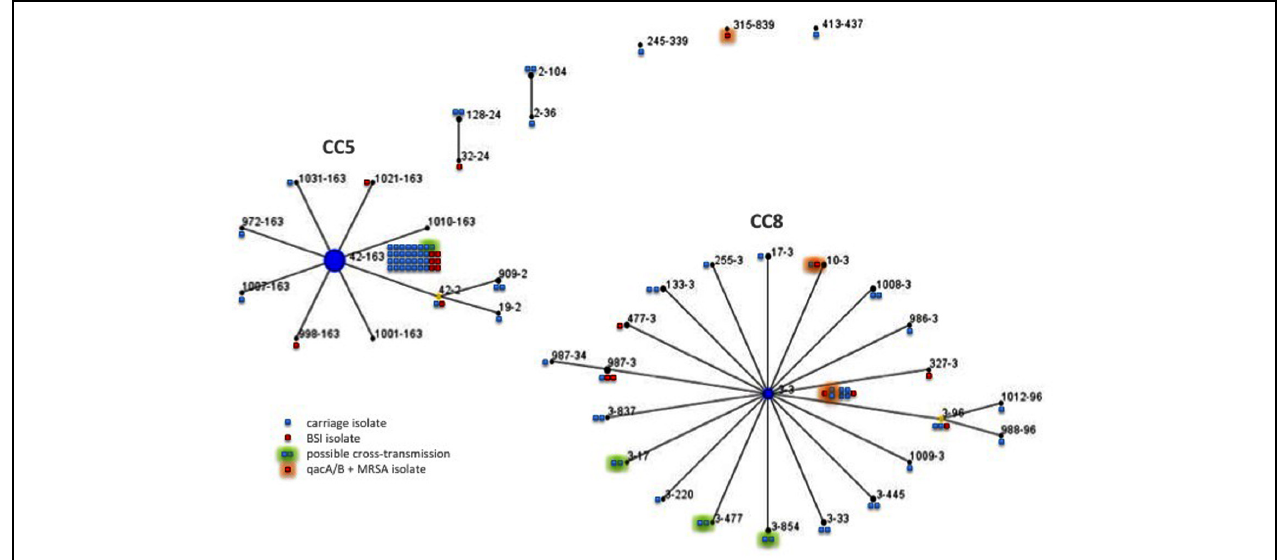
FIGURE 1 | Double locus sequence typing (DLST) single locus variant (SLV) clustering using eBurst on the 19 BSI-associated and 80 colonizing MRSA isolates. Each circle represents one DLST-type and the number of the squares reflects the frequency of that type among colonizing (in blue) or BSI-associated isolates (in red). Each green halo indicates possible epidemiologically related isolates and black halo indicates isolates carrying qac A/B gene. Linked DLST-type differ at one of the two loci ( clfB or spa